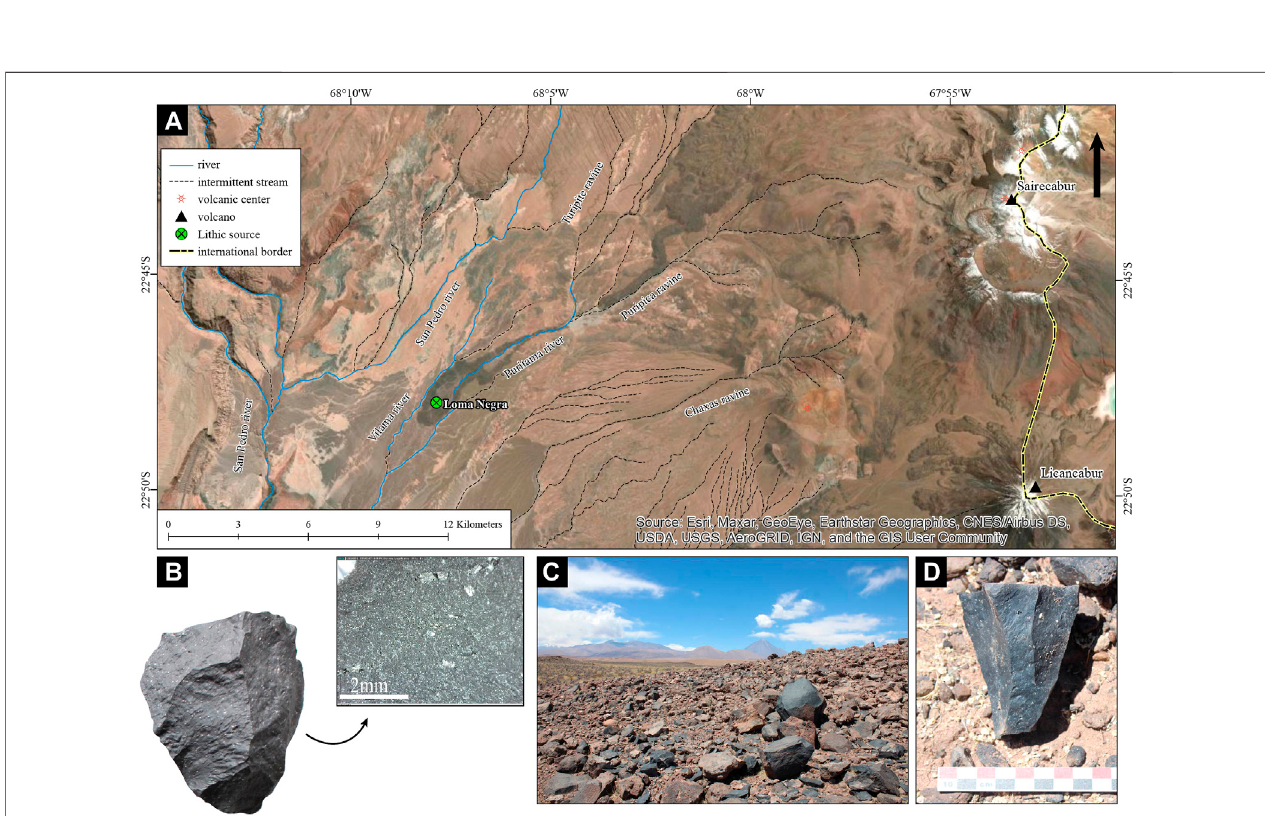
FIGURE 4 | Loma Negra-Puripica source: (A) geological context; (B) raw material sample; (C) quarry-workshop site; (D) discarded blade core of black andesite.